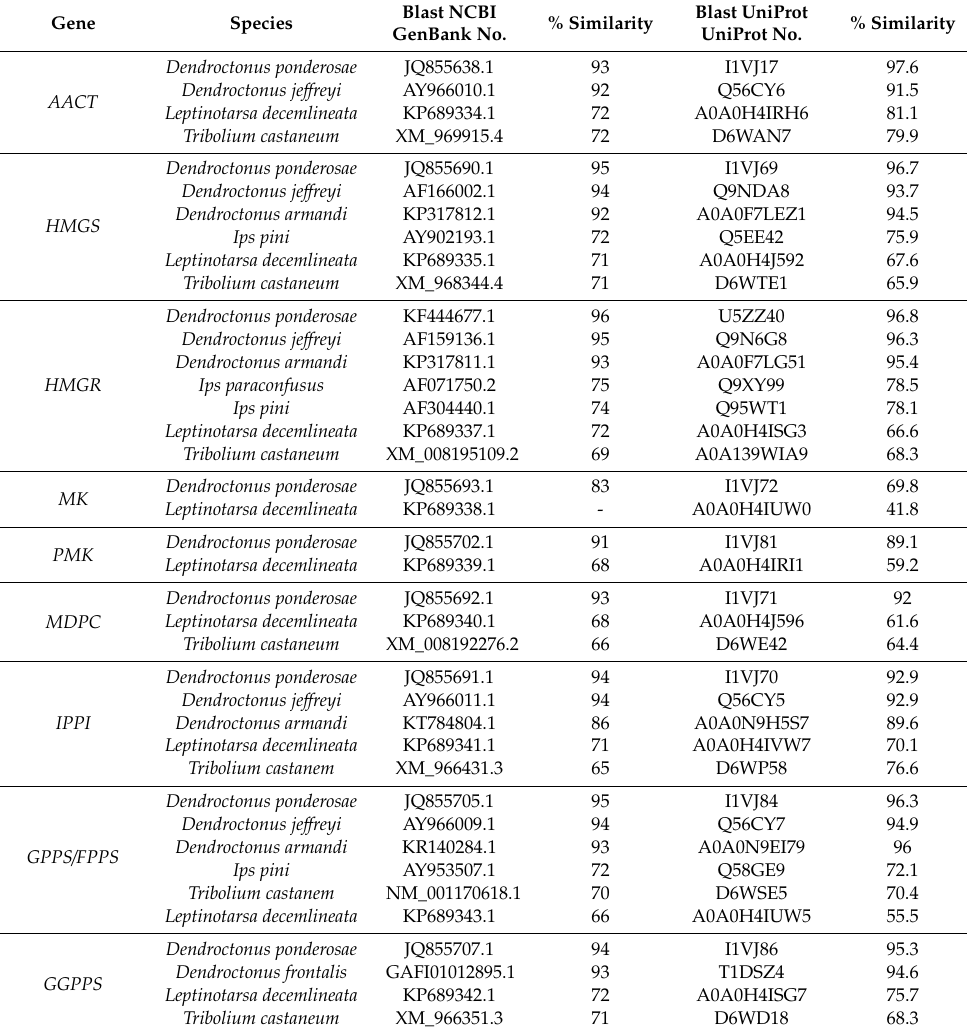
Table 1. Nucleotidic and aminoacidic similarities from mevalonate (MVA) pathway sequences isolated from D . rhizophagus compared with previously reported Dendroctonus species and other coleopteran sequences. (NCBI, National Center of Biotechnology